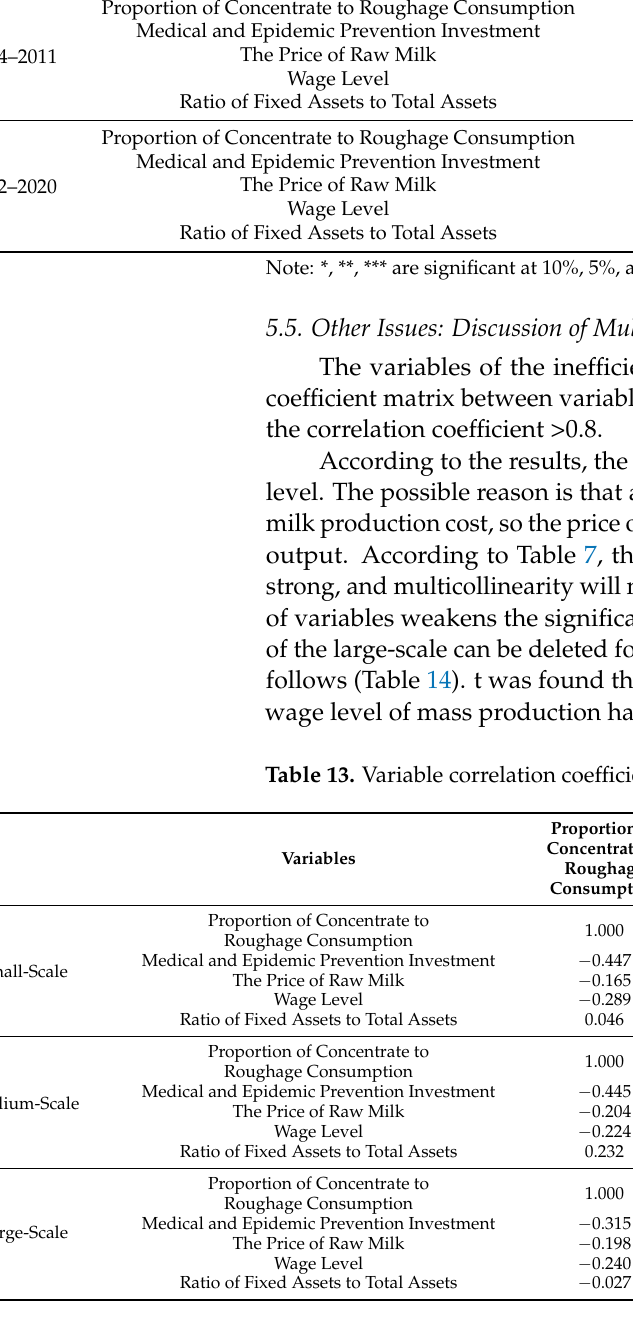
Table 14. Regression results after deleting